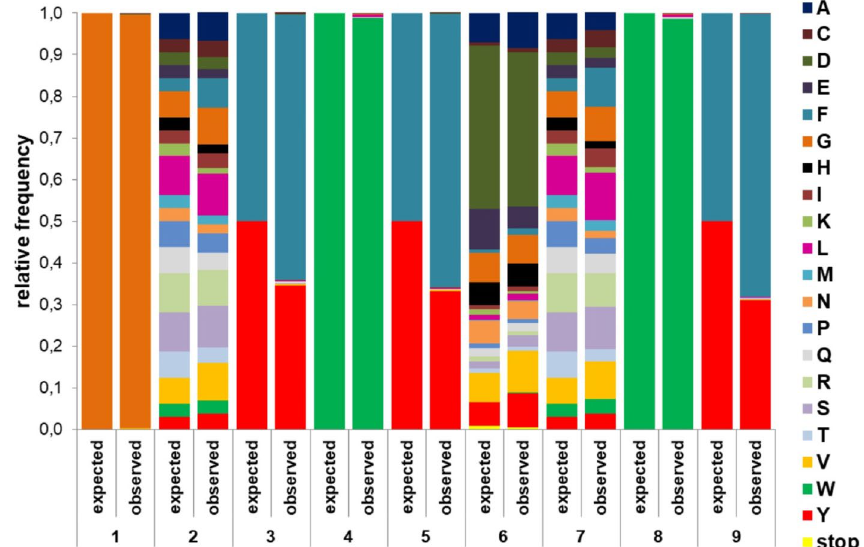
Figure 2. Relative expected and observed frequencies of amino acid residues at individual peptide positions of the pre-screened phage